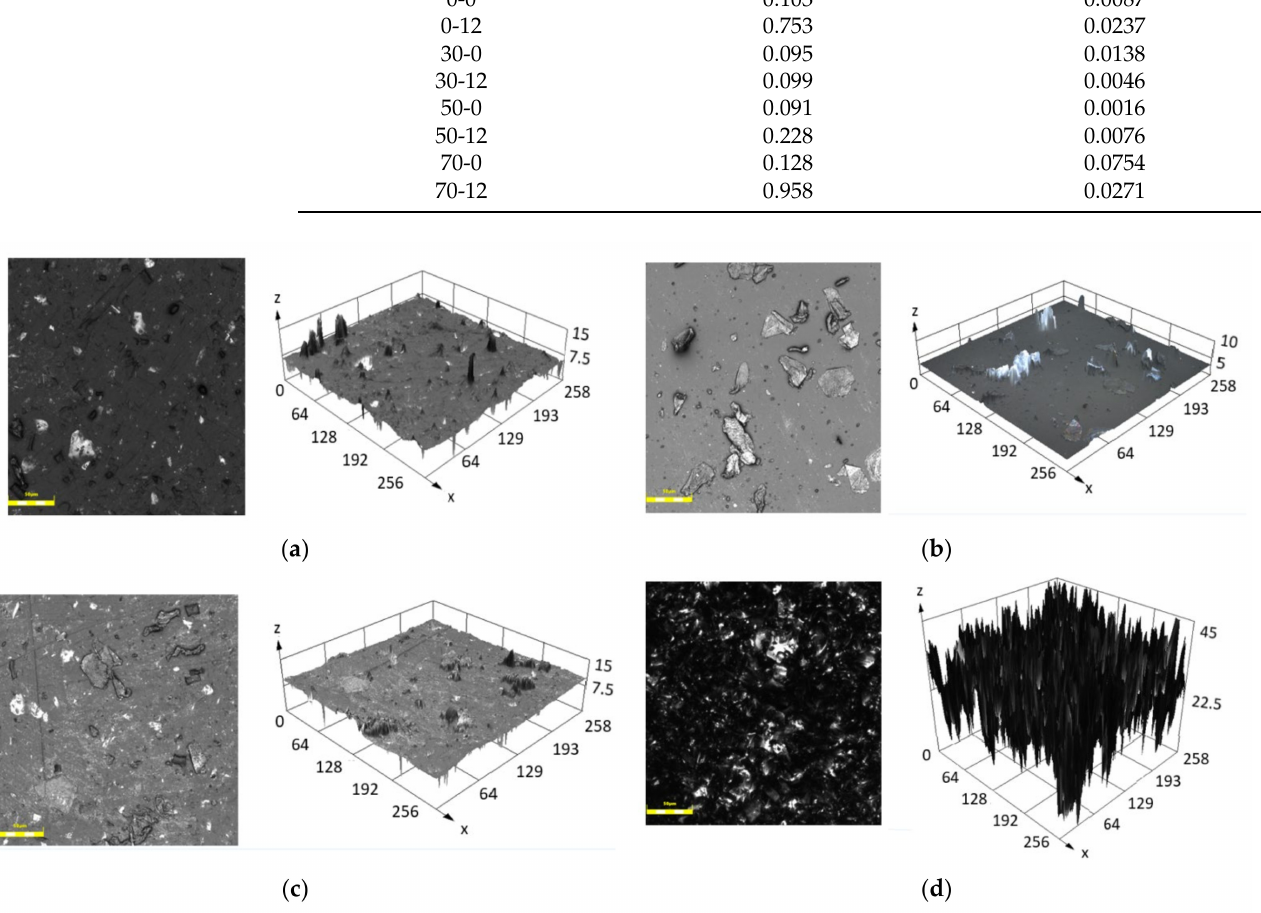
Figure 7. CLSM analysis of the examined surfaces for the samples, 2D and 3D view: ( a ) 50-0, ( b ) 70-0, ( c ) 50-12, ( d ) 70-12. Scale bar ~50 µ